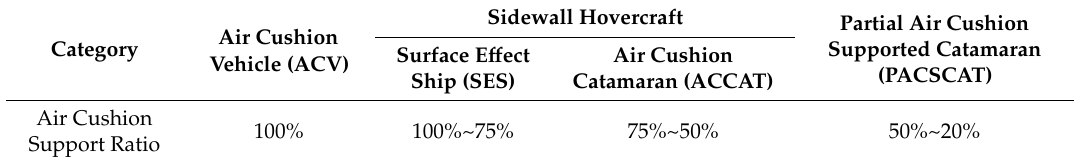
Table 1. Categories of air cushion assisted vessels by air cushion support